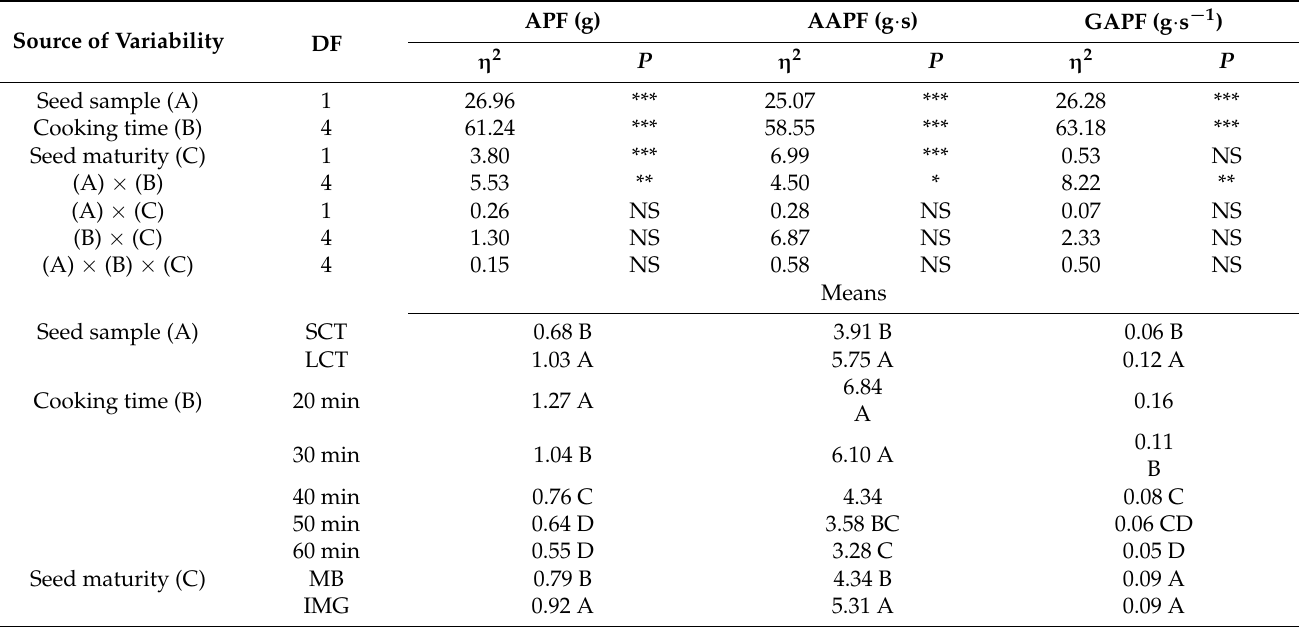
Table 2. Analysis of variance for average texture analysis parameters APF (absolute positive force), AAPF (area to absolute positive force), and GAPF (gradient to absolute positive force) of short (SCT) and long (LCT) cooking time lentil seeds, respectively, during cooking at 100 ◦ C for 20–60